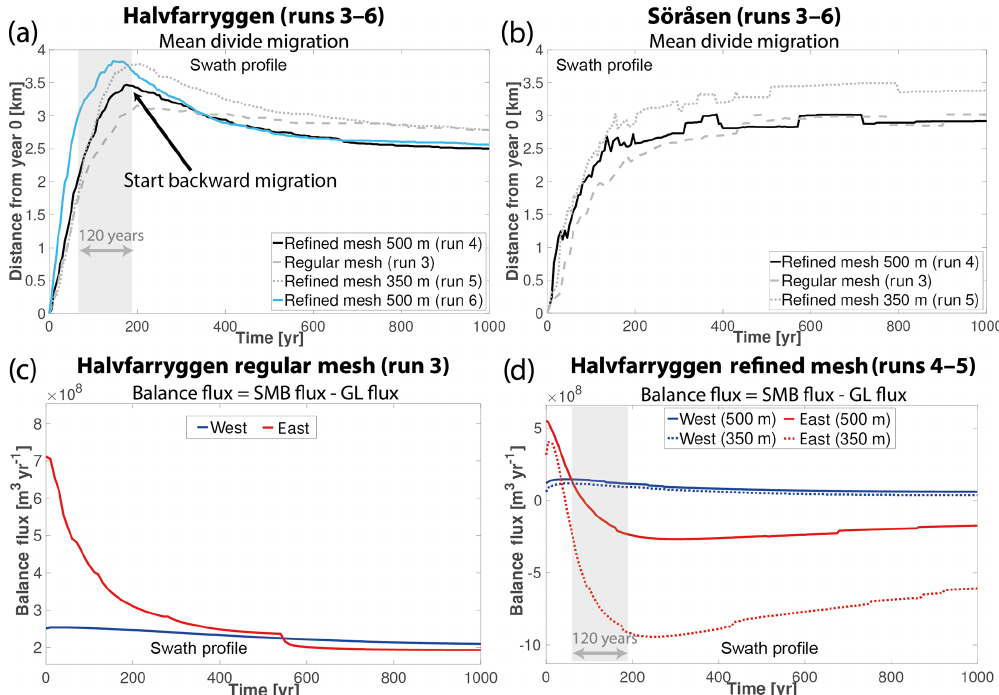
Figure 6. Ice-rise divide migration for (a) the Halvfarryggen Ice Rise and (b) the Söråsen Ice Rise induced by surface mass balance pertur- bation for different mesh resolutions. Positive numbers indicate migration to the east. Panels (c) and (d) show balance fluxes for the eastern and western side of the divide to the grounding line for the Halvfarryggen Ice Rise. Grey shaded areas in (a) and (d) highlight the time lag between the balance flux east being smaller than the corresponding flux west and the start of backward migration. “Swath profile” indicates that computed divide migration is averaged over cross sections shown in Fig. 7. For the grounding line (GL) flux, this means that the flux is summed along the current grounding-line position over the swath length. The surface mass balance (SMB) flux is area averaged from the current divide position to the respective grounding-line position in the east and west of the divide over the swath length. Note different y -axis scales in (c) and (d)